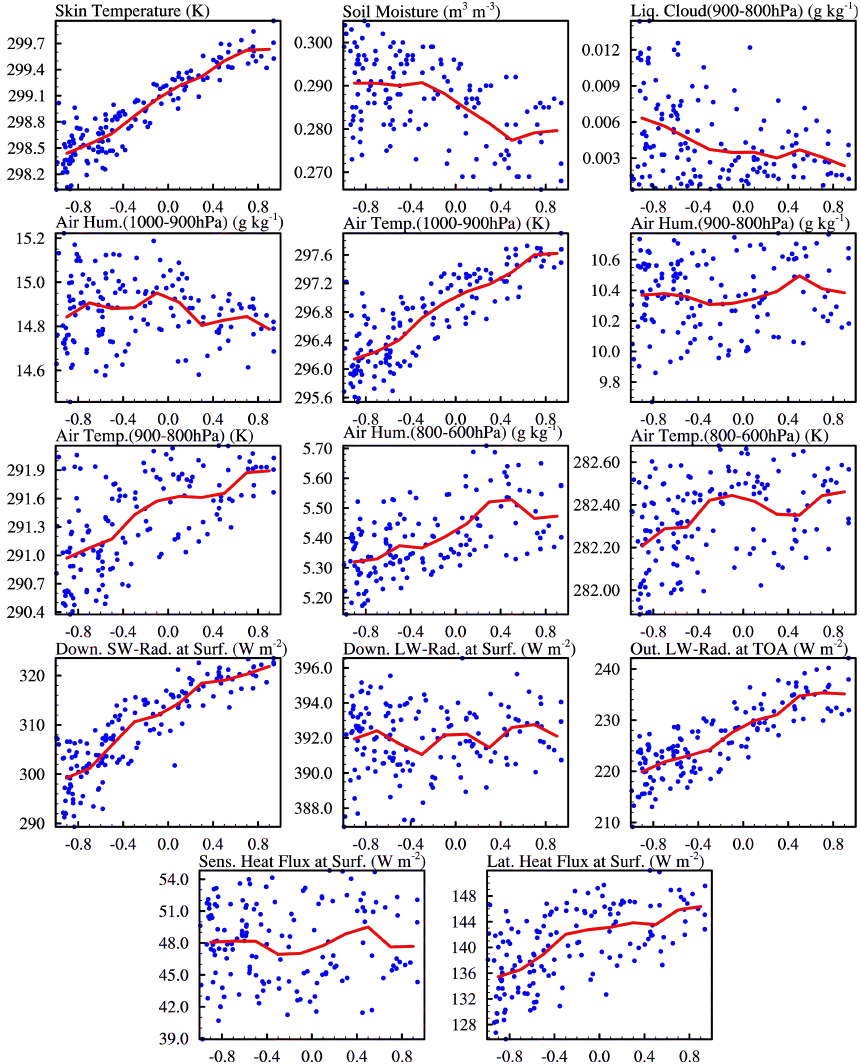
Fig. 9. Same as Fig. 8 except for the entrainment rate related parameter P e